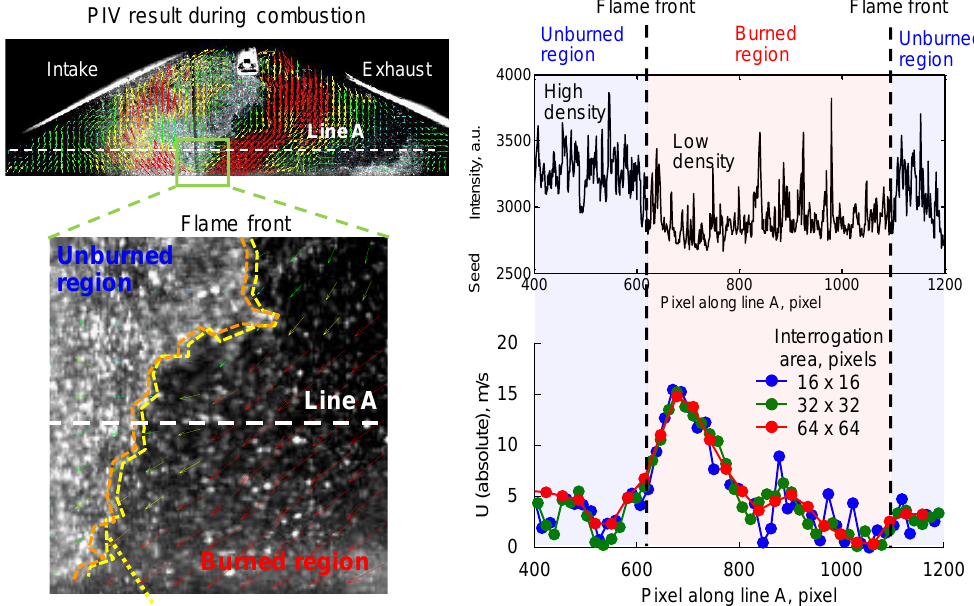
Figure 7. Effects of the flame front on derived velocity from combustion PIV at the flame front. PIV image and schematics of the analysis ( left ) and plots of the intensity across the measurement area on one line as well as the velocity calculated from different interrogation area ( right ).